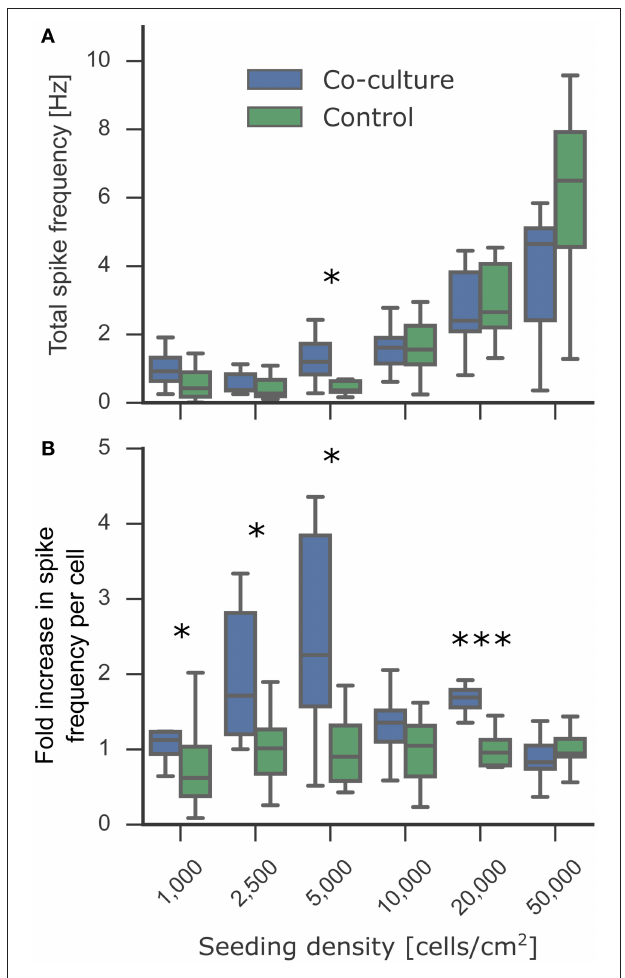
FIGURE 5 | Effect of astrocyte co-culture on the spiking activity of low-density neuronal cultures. The cultures were transduced with the gene-encoded calcium indicator GCaMP6f at 7 DIV. At 14 DIV, the activity of the experimental neuronal cultures was measured using the fluorescent calcium indicators. To obtain the spiking activity, the calcium activity videos were segmented into individual cells followed by spike detection. (A) Spontaneous activity was detected in all cultures down to 1,000 cells/cm 2 . The culture-wide spike frequency increases progressively with the seeding density. (B) The fold increase in spike frequency per neuron between the co-cultured and control experimental neuron cultures showed an increase in spike frequency at low densities. In the plot, the box corresponds to the first and third quartiles with the median. The median is indicated with a horizontal line in the box, and the maximum and minimum are at the ends of the whiskers. Measurements 1.5 interquartile ranges below the first quartile or above the third quartile are classified as outliers and excluded. Statistical significance was tested using Mann-Whitney U -test with significance levels: * if p < 0.05; *** if p <